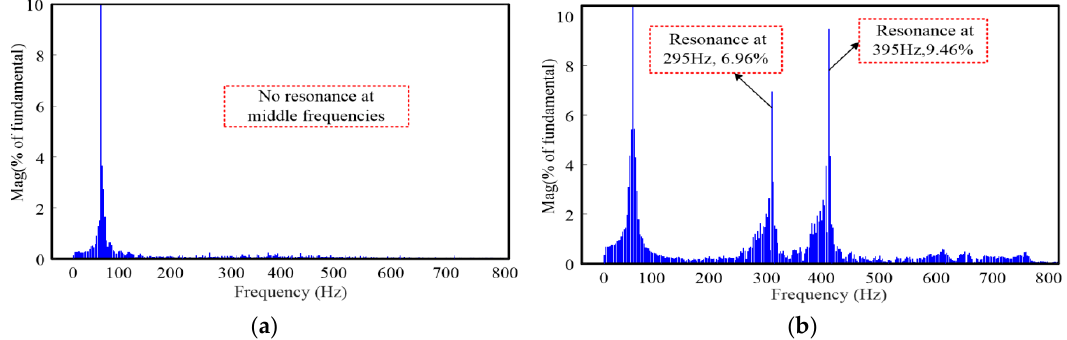
Figure 19. FFT analysis of stator voltage (a) Low bandwidth SRF-PLL; and, (b) High bandwidth.